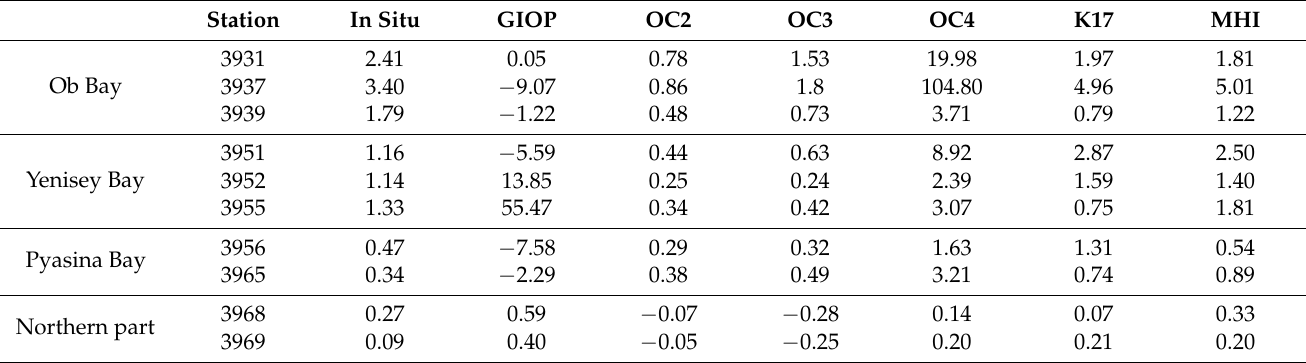
Table 2. Chlorophyll-a concentrations (mg/m 3 ) calculated using in situ Rrs data.